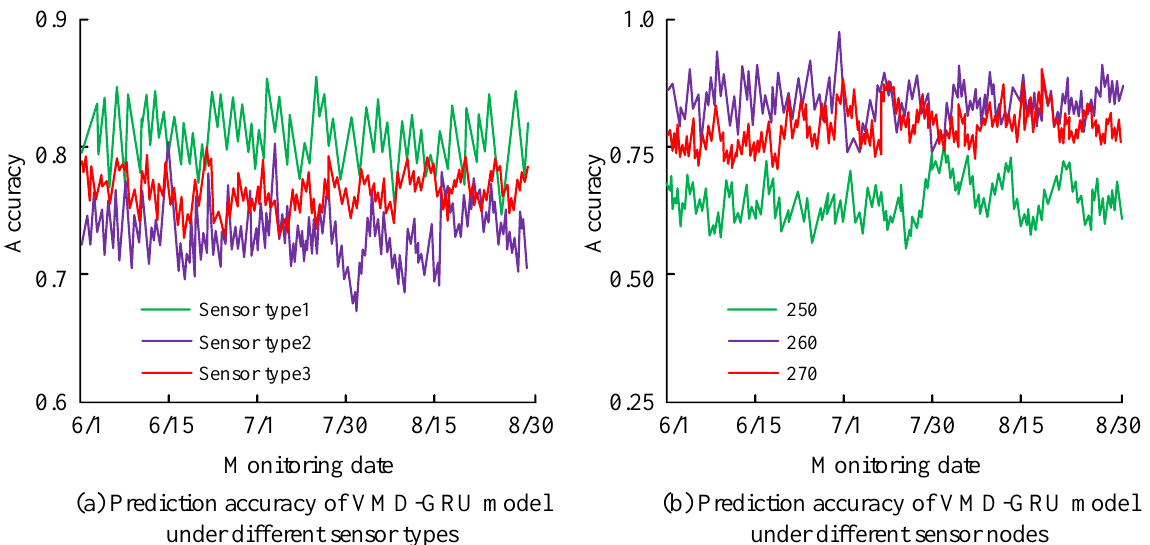
Figure 9. Prediction accuracy of VMD-GRU model under different sensor types and number of sensor nodes.